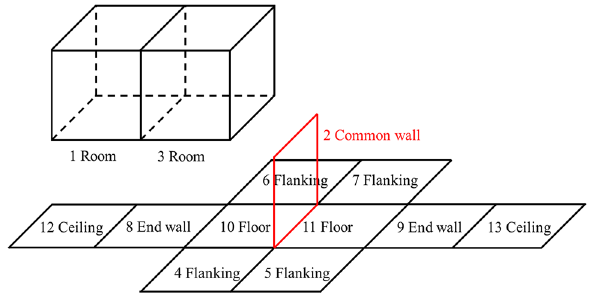
Fig. 1 Exploded view of a system consisting of one room